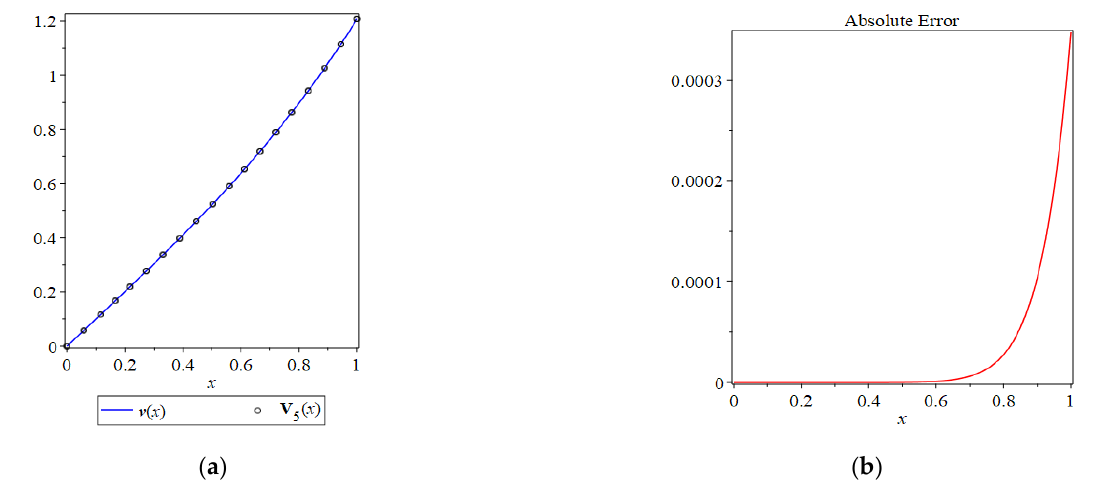
x V ; ( b ) absolute error 5 x V . 5 V x 5 0.0